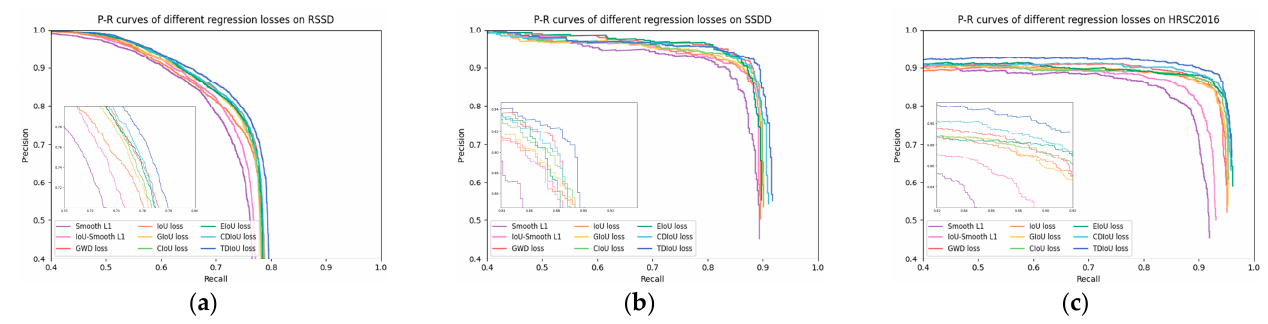
Figure 20. P–R curves of RetinaNet-R based on different regression losses on ( a ) RSSD, ( b ) SSDD, and ( c ) HRSC2016.